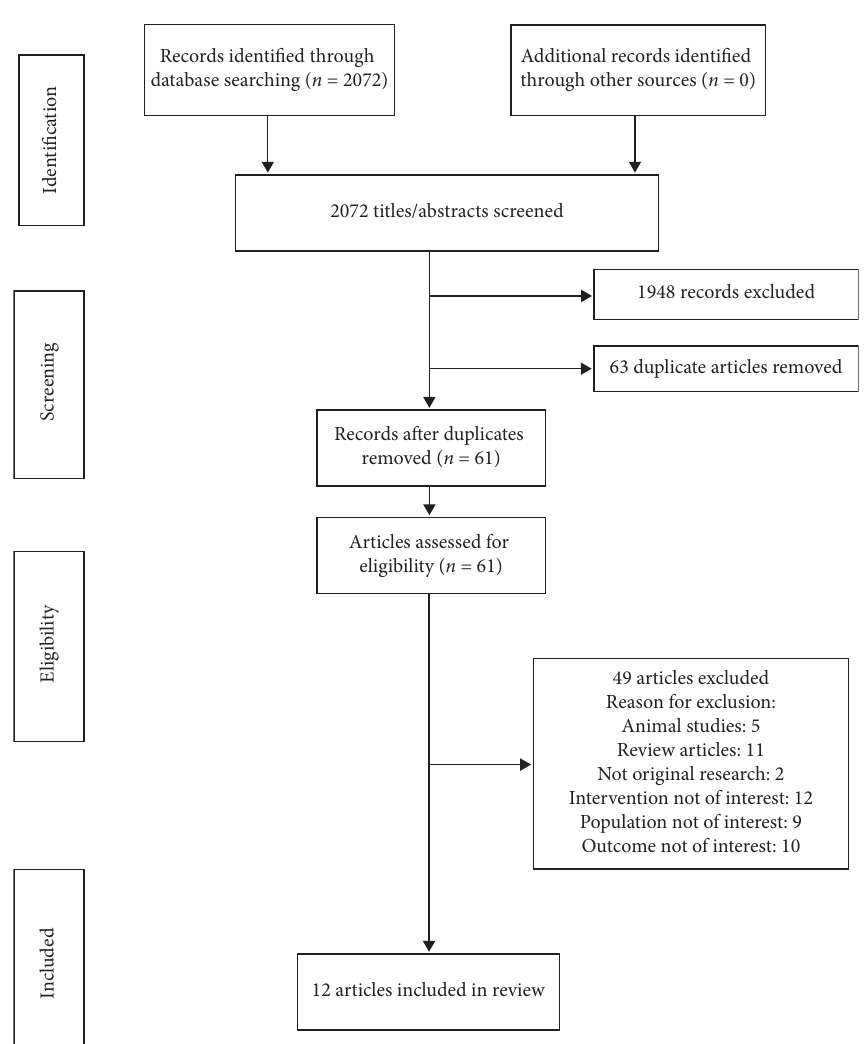
Figure 1: Preferred Reporting Items for Systematic Reviews and Meta-Analyses (PRISMA) flow diagram of articles included in systematic